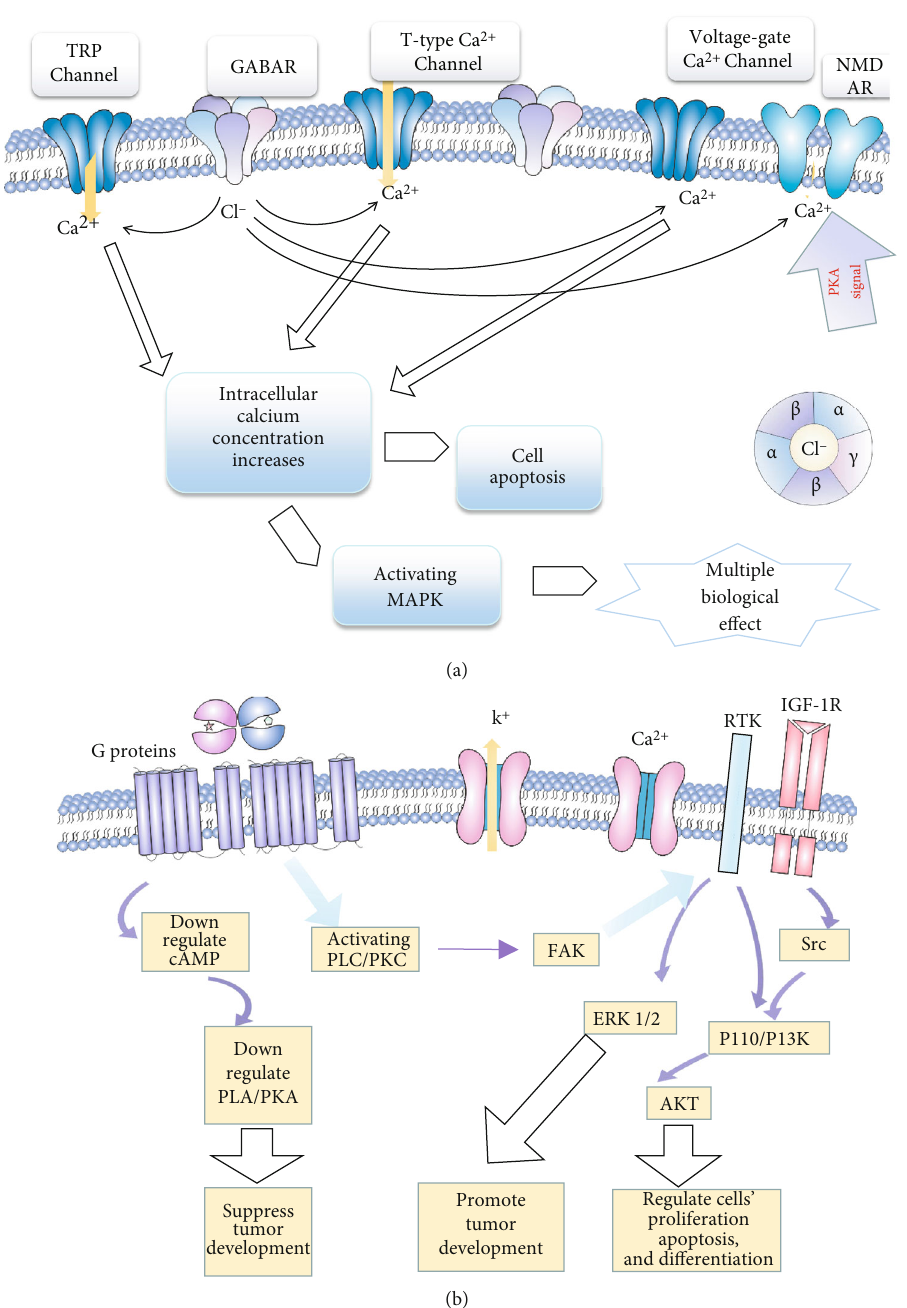
Figure 1: The functions and molecular mechanism of GABA and its receptors in cancer development. (a) The GABARs contain 5 major subunits, and stimulation of GABAR with GABA will activate the chloride ion channel. The change of electric potential further activates the calcium ion channel and increases the intracellular calcium concentration. The activation of the PKA pathway also increases calcium concentration. The higher concentration of calcium promotes tumor cell apoptosis and activates the MAPK pathway to achieve multiple biological e ff ects. (b) The GABBRs are G protein-coupled receptors. When agonists are combined, it will suppress the cAMP pathway and promote the PKC pathway. PKA suppression inhibits the growth of tumor, while the activation of the PLC/PKC pathway regulates multiple activities via FAK which are associated with IGF1R and RTK. The activation of PKC increases intracellular calcium concentration to induce cell apoptosis. Additionally, other signaling pathways such as YAP also participate in the process of GAGBR- dependent tumor-suppressive or oncogenic